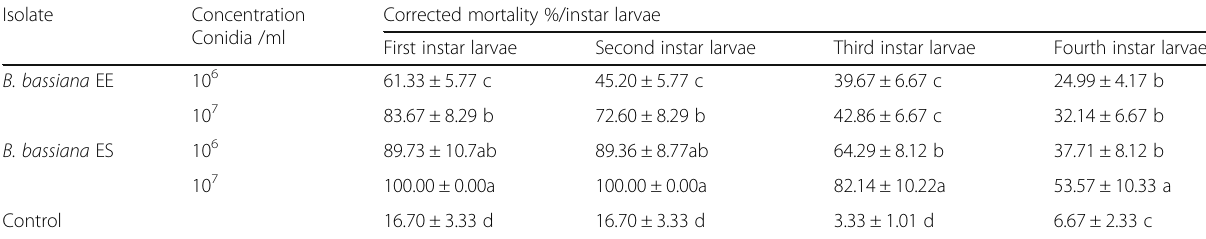
Table 1 Pathogenicity of Beauveria bassiana isolates to squash beetle Epilachna chrysomelina larval instars, 3 days post treatment Isolate